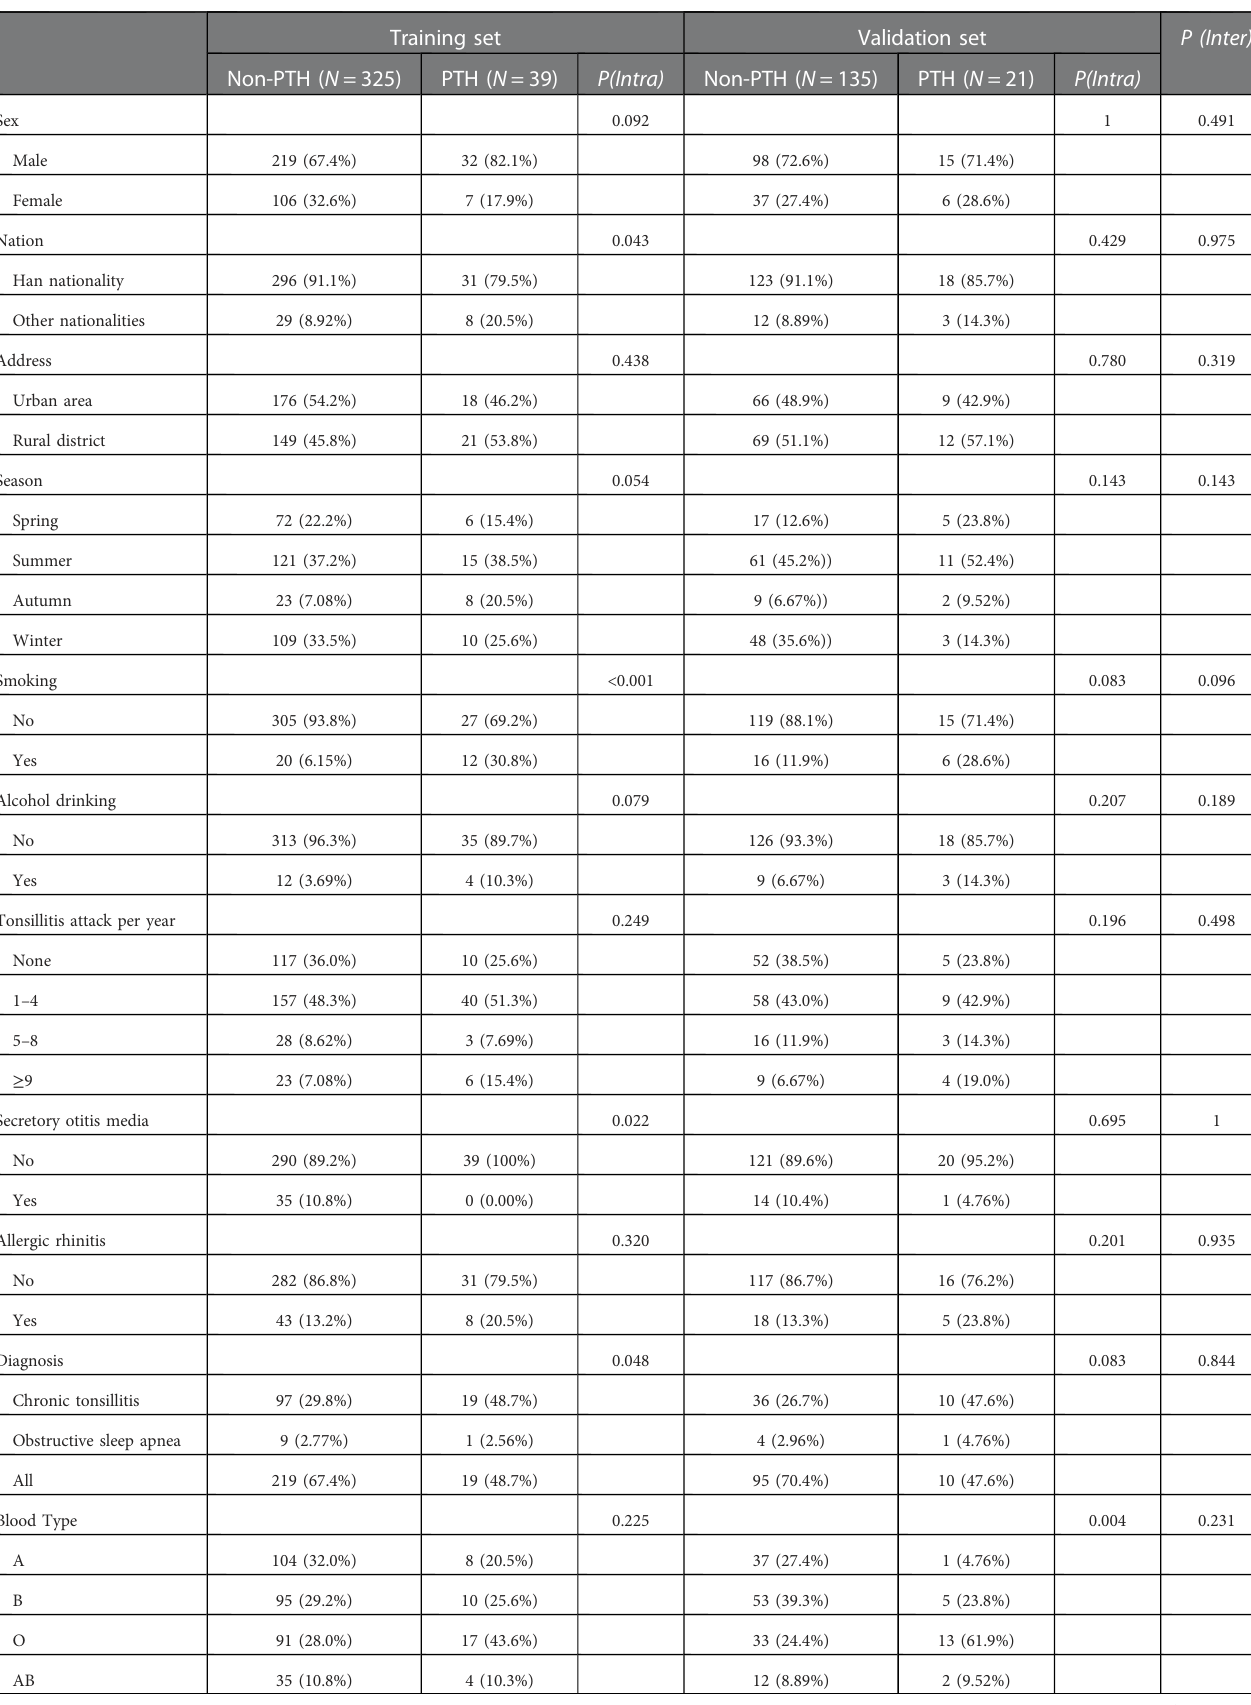
TABLE 1 Clinical characteristics in the training and validation